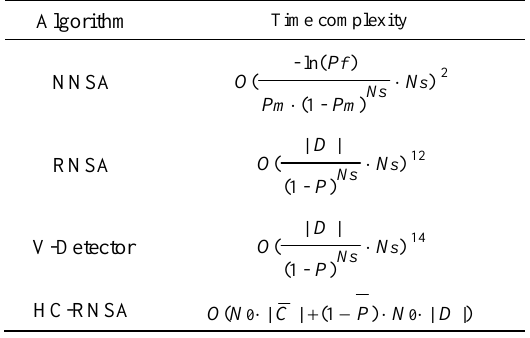
Table 3. Parameter